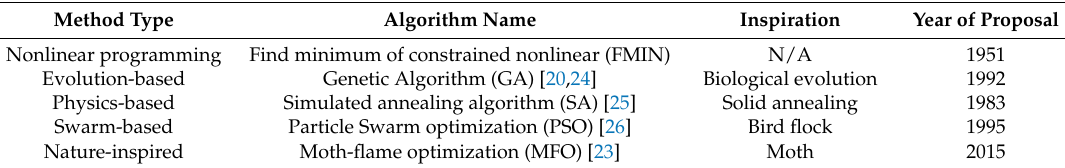
Table 3. Optimization algorithms.